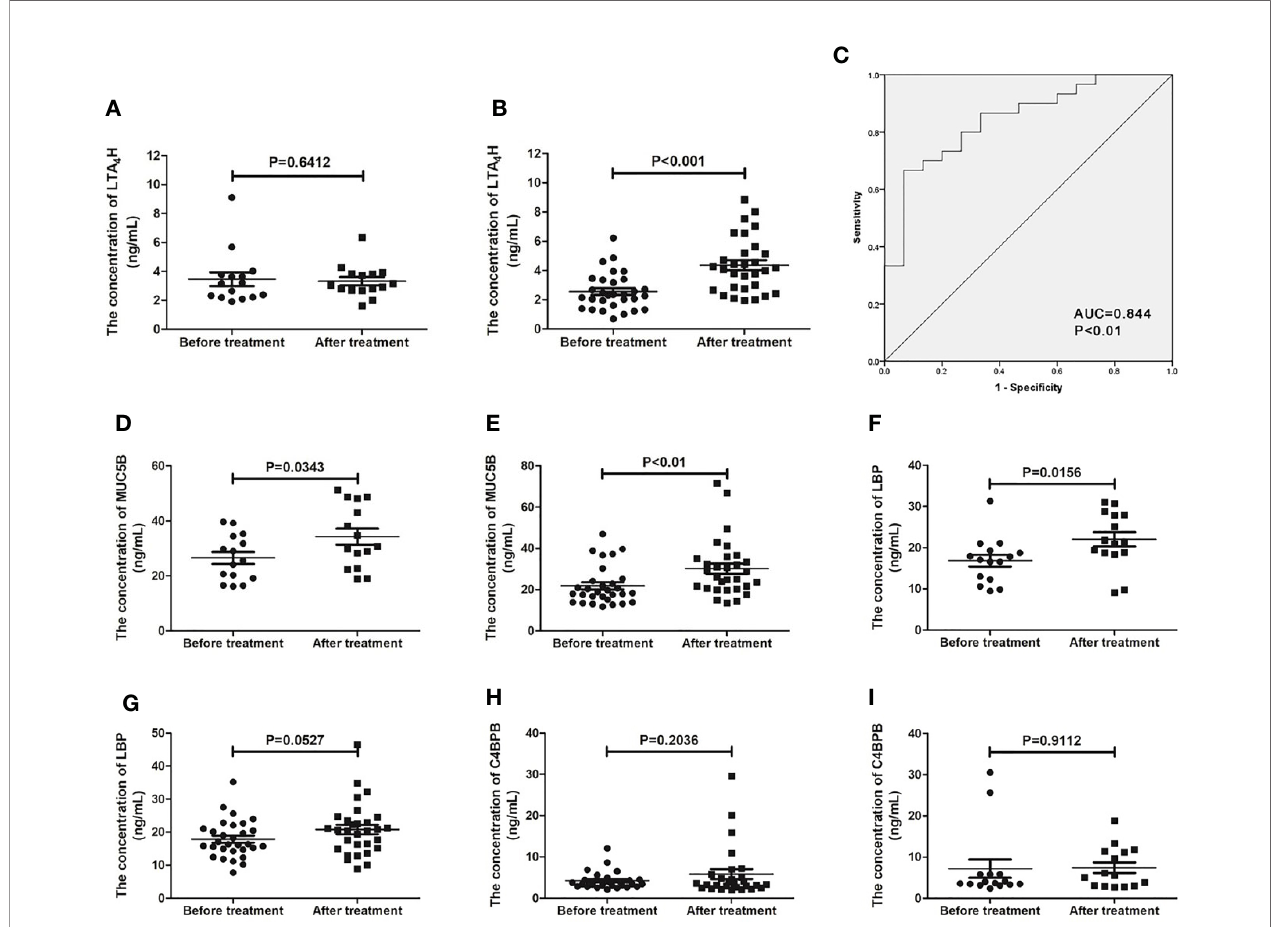
FIGURE 5 | Validation of proteomic prognostic biomarkers using enzyme-linked immunosorbent assay (ELISA). The serum level of LTA 4 H in allergen immunotherapy (AIT) non-responders (A) and AIT responders (B) . (C) Receiver-operator characteristic (ROC) curve of LTA 4 H measured using ELISA. The serum level of MUC5B in AIT non-responders (D) and responders (E) . The serum level of lipopolysaccharide binding protein (LBP) in AIT non-responders (F) and responders (G) . The serum level of C4BPB in AIT non-responders (H) and responders (I)